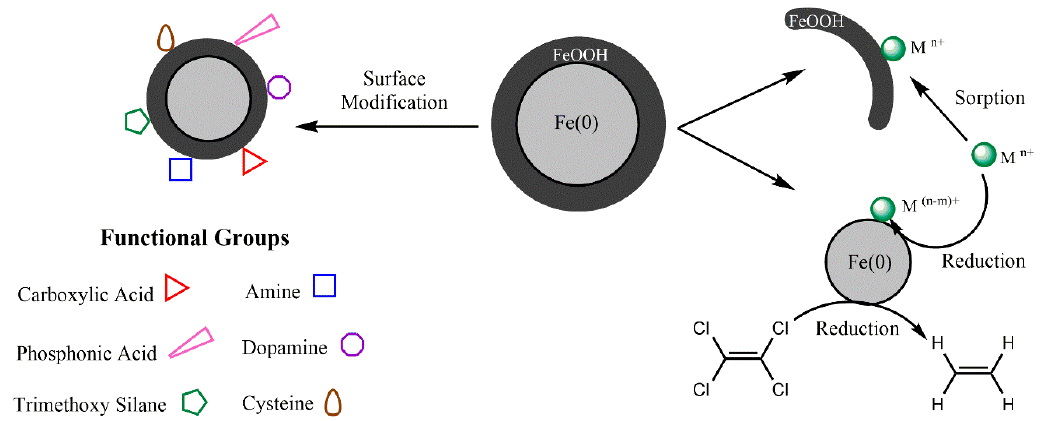
Figure 2. Degradation mechanism of chlorinated contaminants and heavy metals from aqueous systems using iron NPs.